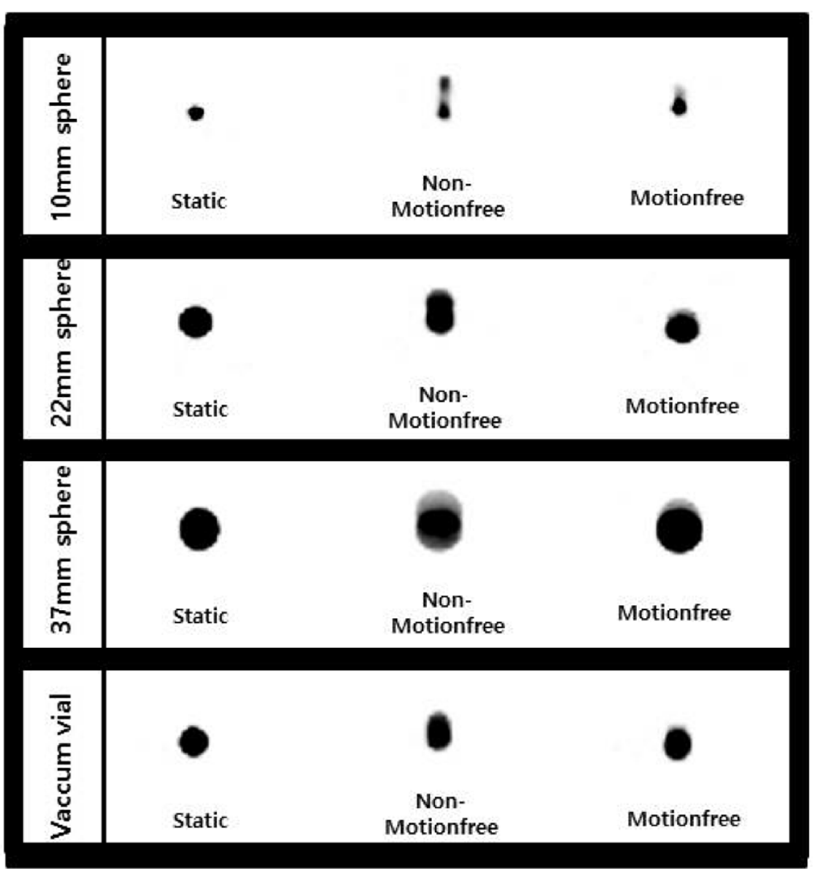
Figure 2. The effects of different distributions of activity according to the MotionFree application in a phantom study. Table 3. The results of the phantom study.